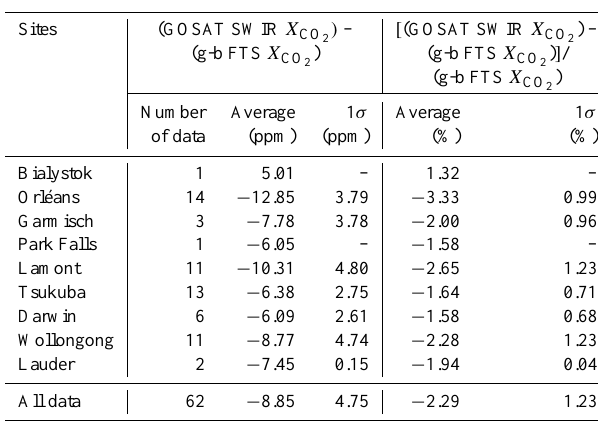
Table 3. Left side: the average and one standard deviation (1 σ) of the difference between GOSAT X CO the nine TCCON sites. Right side: the average and one standard deviation (1 σ) of the difference normalized to g-b FTS X CO in percent). Note that the number of data listed here indicates the count of valid cases in which g-b FTS data were collected within ± 30min of the GOSAT overpass time and corresponding GOSAT X CO values were successfully retrieved. 2